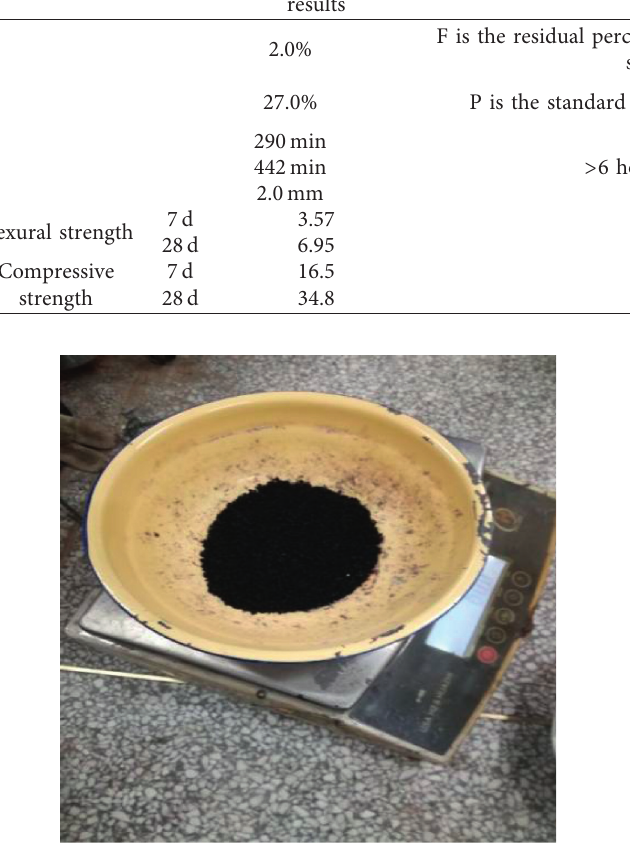
Figure 1: Rubber particles.